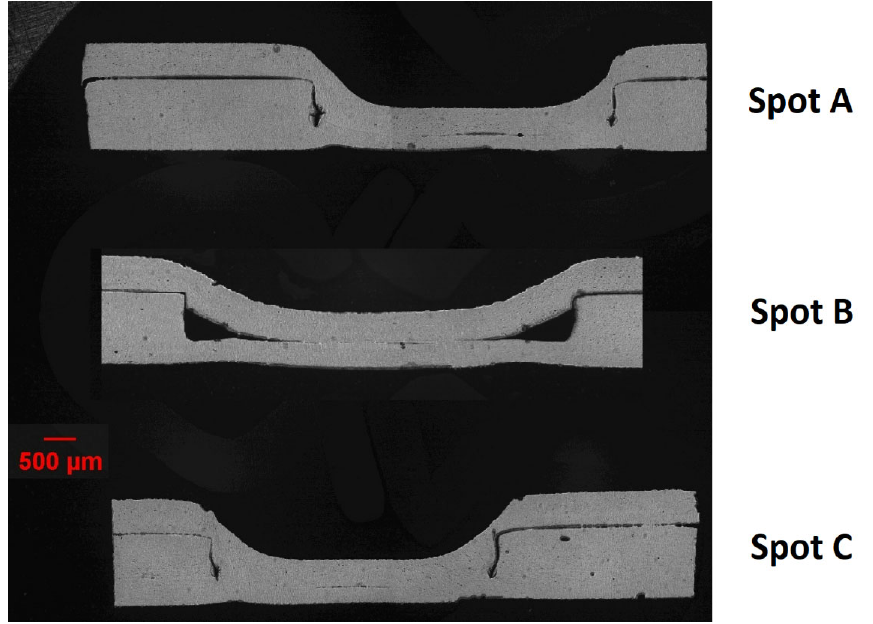
Figure 16. The cross-sectional images of the three spots in the sample. The spot locations are indicated in Figure 2.